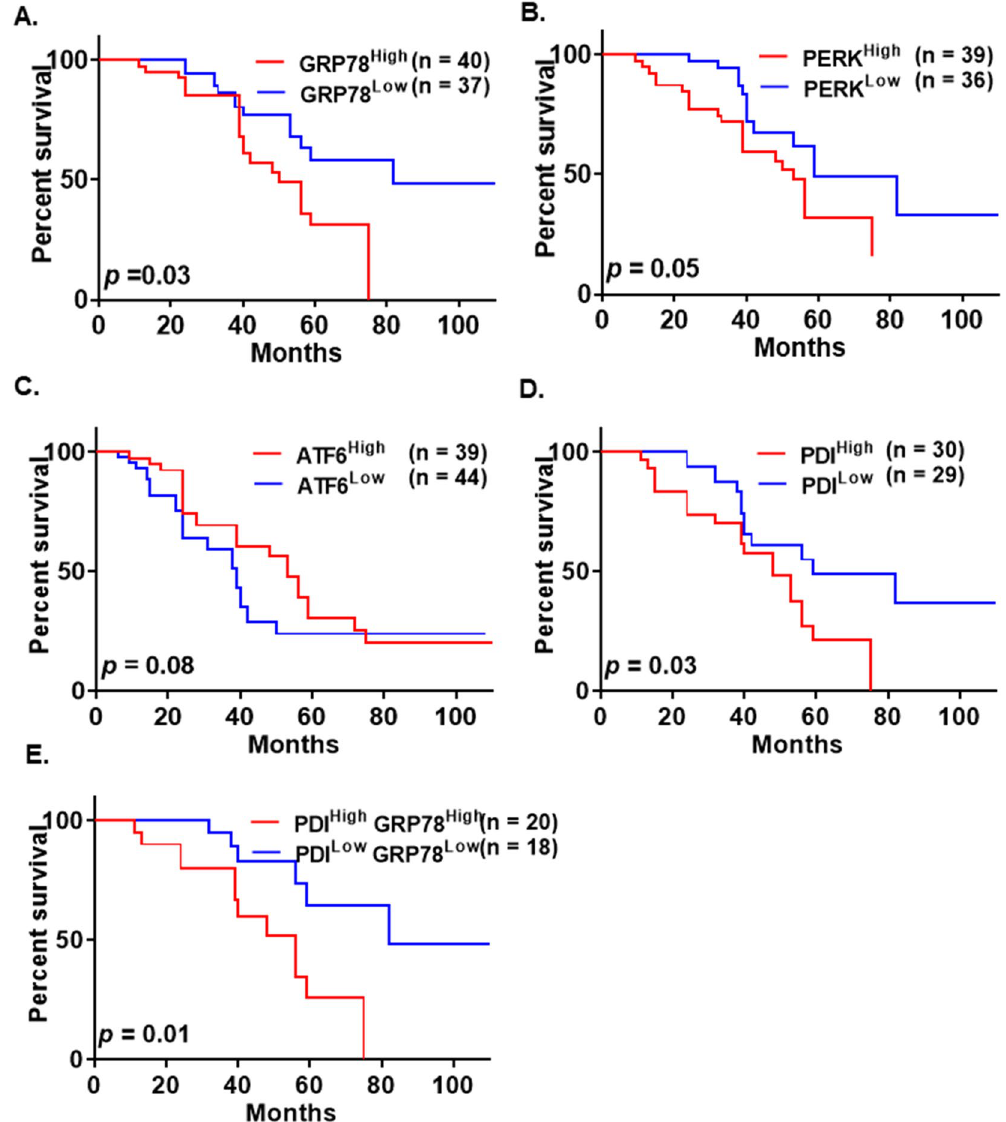
Figure 5. Correlation of GRP78, PERK ATF6 and PDI expression levels with overall survival rate in high-grade serous ovarian cancer patients. Overall survival curves for patients based on GRP78 ( A ), PERK ( B ), ATF6 ( C ), and PDI ( D ) expression levels. ( E ) Overall survival curve for EOC patients based on combined expression levels of GRP78 and PDI. Overall survival data sets were obtained from the UM subset of patients with high- grade serous EOC and analyzed with Prism 6 (GraphPad Software, Inc.). The Kaplan-Meier survival analysis method was used to generate survival curves using low ( < median expression) and high expression ( > median expression) groups. For the PDI survival curve, part of the data was used in previously published article 25